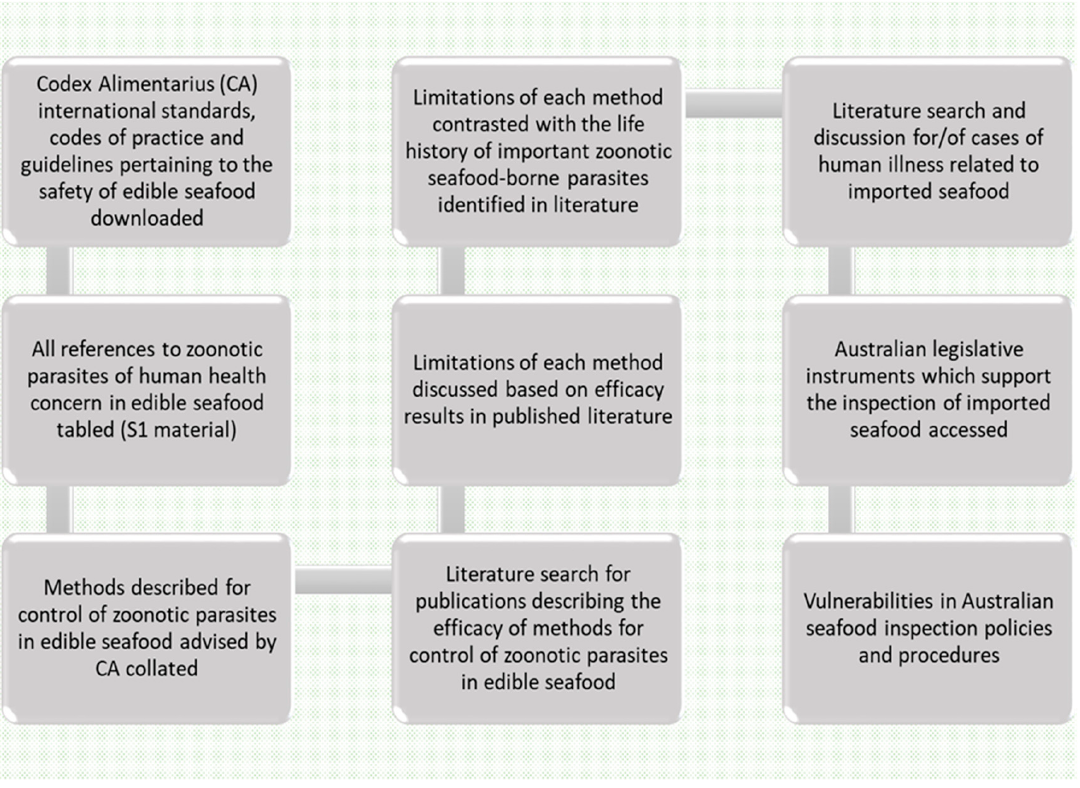
Figure 1. Flow diagram of the process used to develop the critical appraisal.